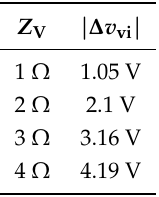
Table 6. Voltage steady-state deviations depending on virtual-impedance